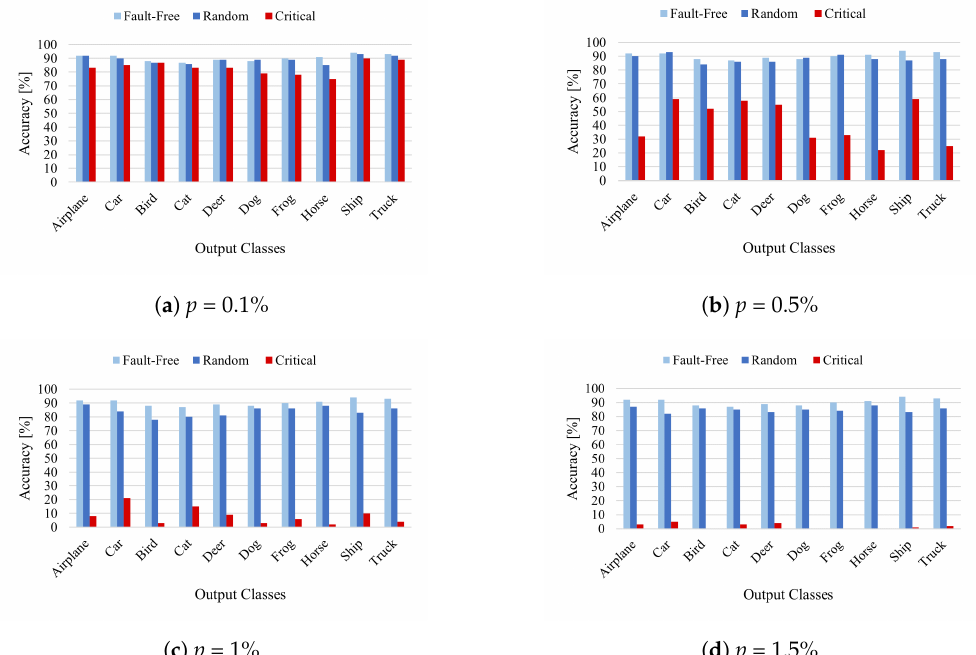
Figure 6. CIFAR-10 All-CNN: software fault injection campaigns on random and critical neurons. A fixed percentage p of neurons is